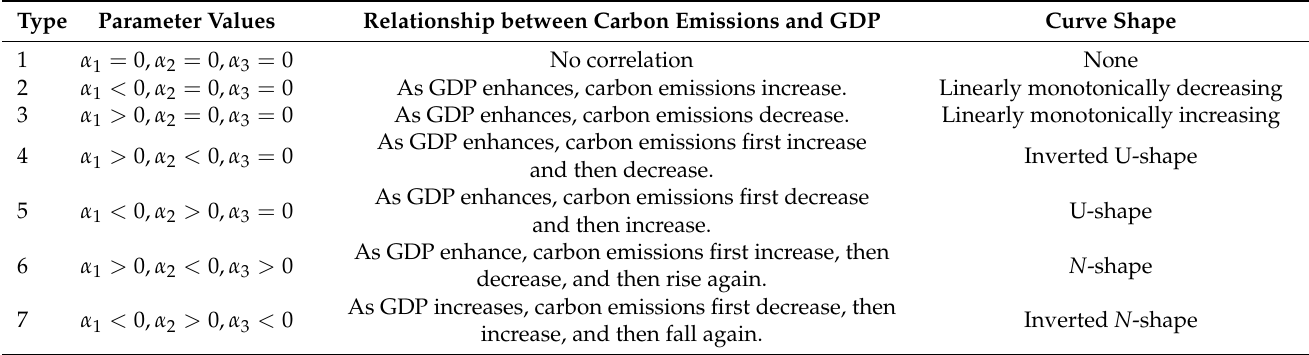
Table 1. EKC curve and curve shape analysis.